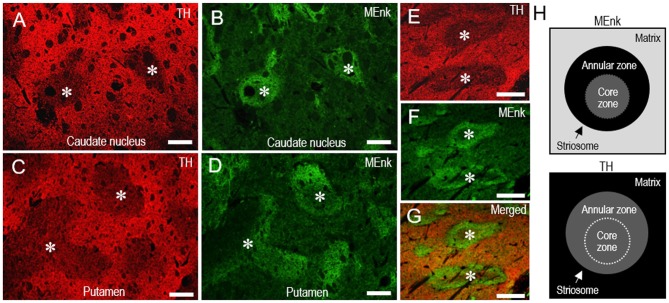
Pattern of localization of TH in the striosome-matrix domains of the human neostriatum. (A–D) Photomicrographs of the CN (A,B) and putamen (C,D) double-stained for TH (A,C) and MEnk (B,D). Corresponding striosomes are indicated by asterisks. (E–G) Photomicrographs of an area of the putamen double-stained for TH (E) and MEnk (F), with a merged image (G). Corresponding striosomes are indicated by asterisks. Note that the margins of the TH-poor zones correspond to the outer margins of the striosomes enriched in MEnk. (H) Depicted are the patterns of localization of MEnk (upper) or TH (lower) in the striosome-matrix system. The striosome consists of annular and core zones. Higher densities of TH or MEnk-immunoreactive products are indicated by higher gray-scale levels. Scale bars: (A–D) 500 μm, (E–G) 250 μm.